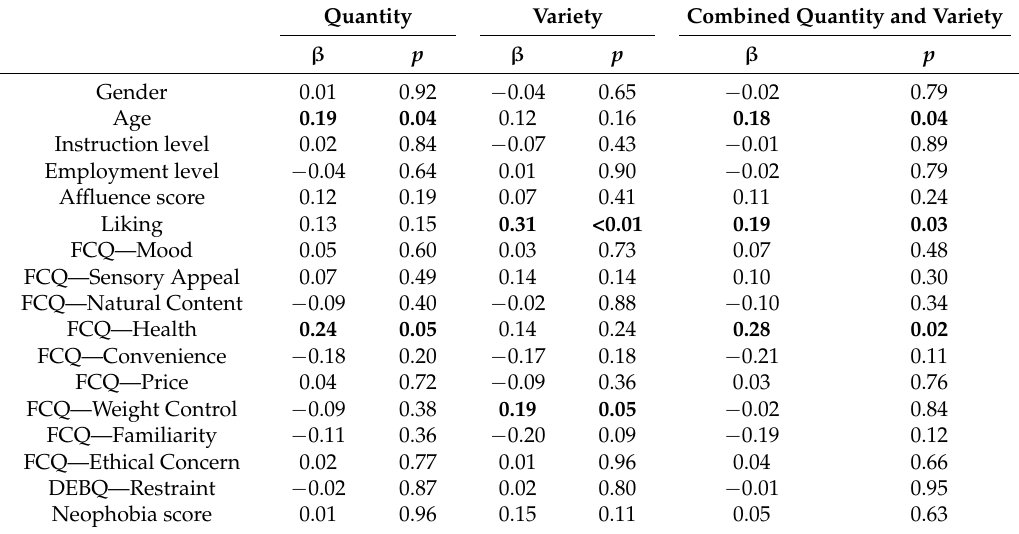
Table 6. Results of the regression analyses using demographic characteristics and all liking and attitude variables to predict quantity, variety and combined quantity and variety scores in UK participants ( n = 158). Regression equations: Quantity: R = 0.36, R 2 = 0.13, adjusted R 2 = 0.03, F (17,157) = 1.26, p = 0.23; Variety: R = 0.49, R 2 = 0.24, adjusted R 2 = 0.15, F (17,157) = 2.64, p < 0.01; R = 0.43, R 2 =